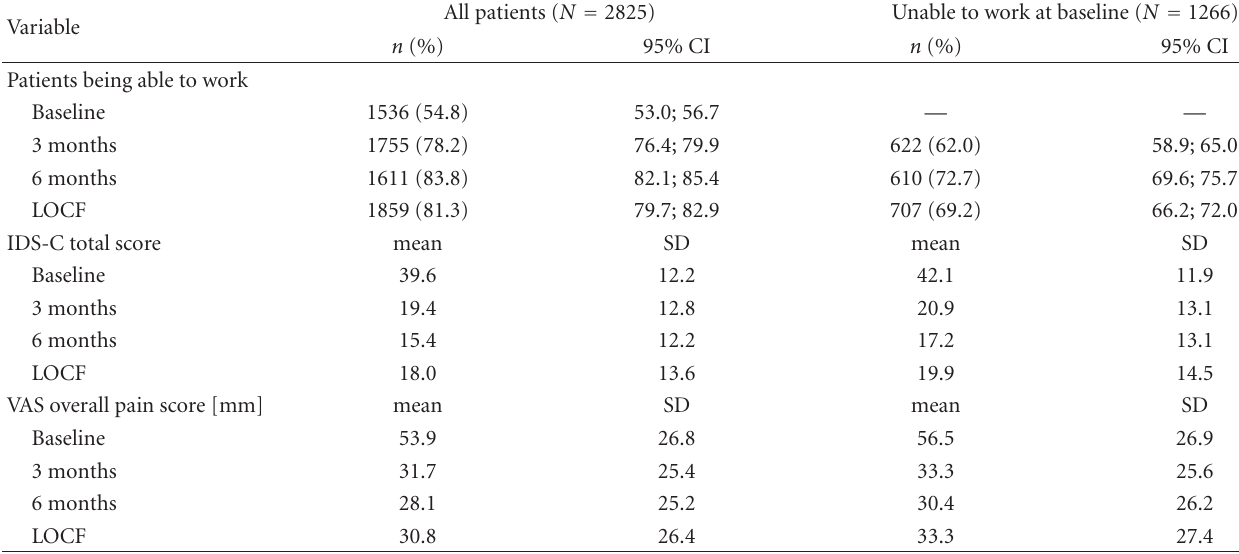
Table 2: Working ability, depression, and pain scores over time: all patients and patients unable to work at baseline. Variable